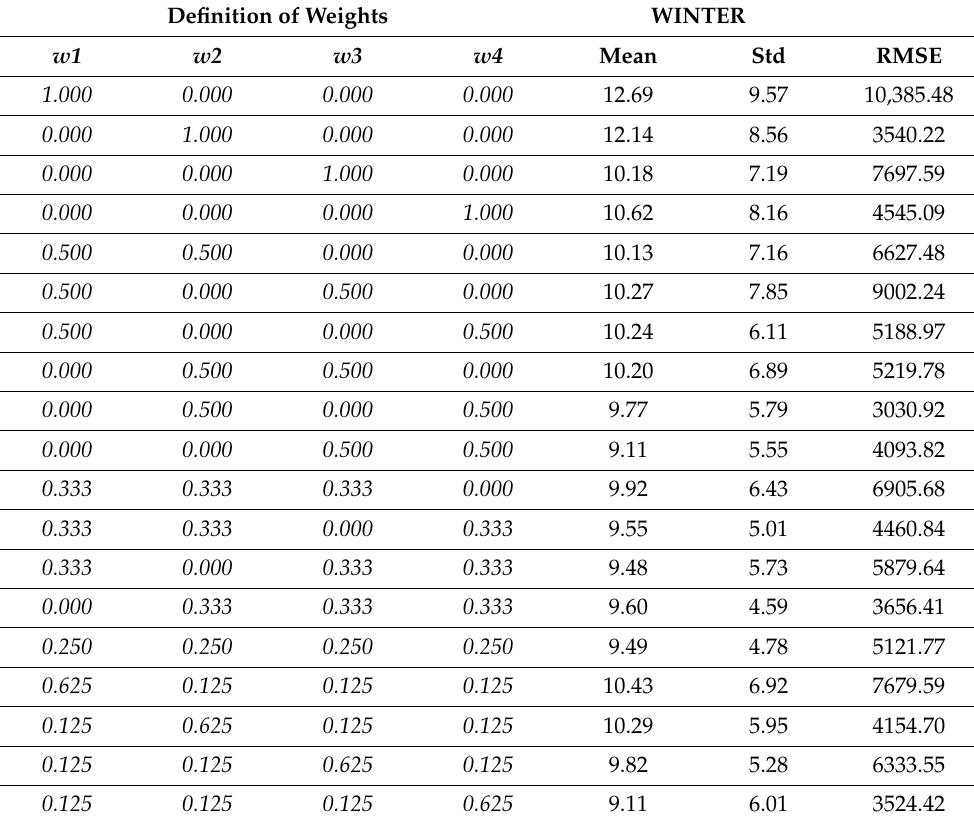
Table 7. Mixture DOE arrangement considering four elements to be combined. Results for winter are